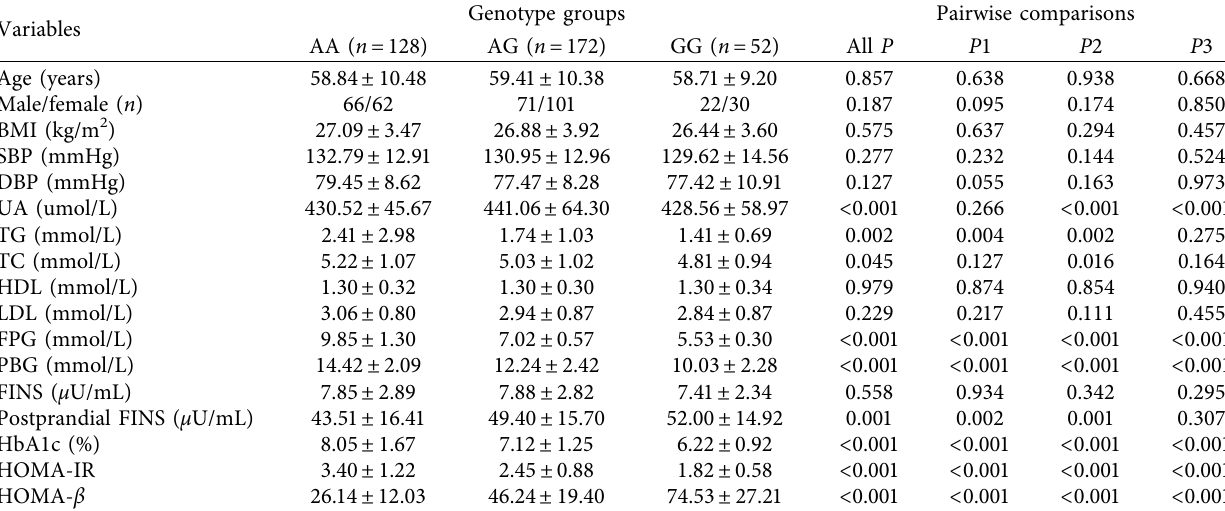
Table 6: Comparison of biochemical indices of the SLC2A9 A/G (rs1014290) SNP among the diferent genotypes in the T2DM group.